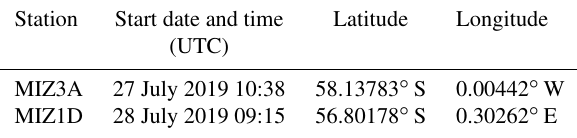
Table 1. List of ice sampling stations.